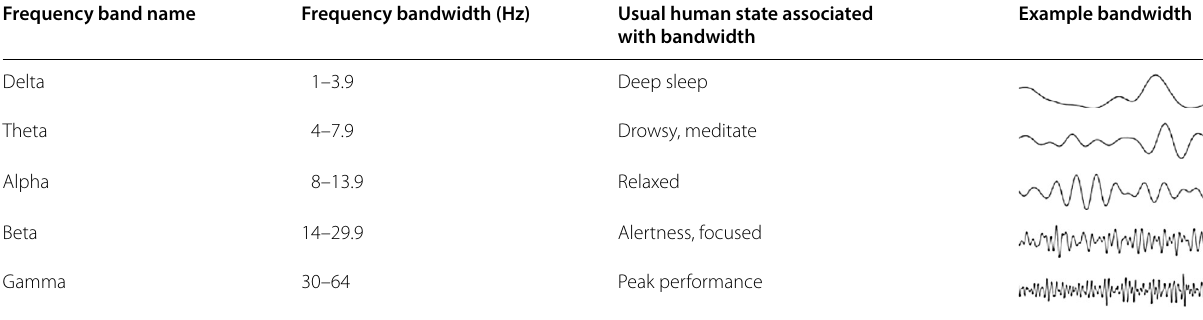
Table 8 EEG sub-band frequencies